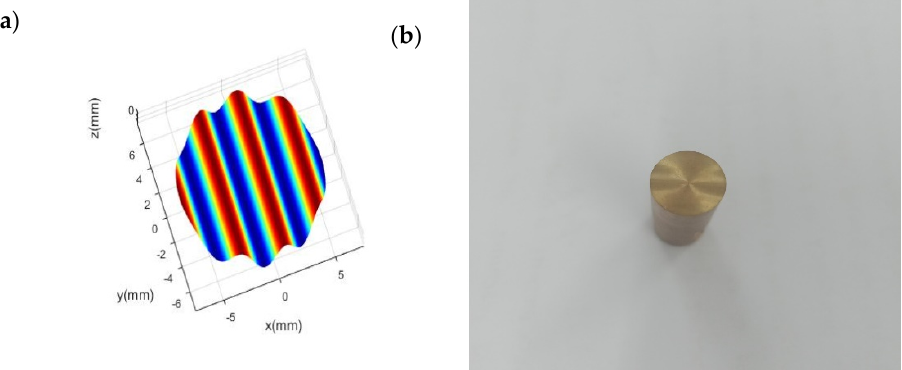
Figure 22. ( a ) Simulated sinusoidal wavy surface. ( b ) The sinusoidal wavy surface machined by the FTS mechanism.